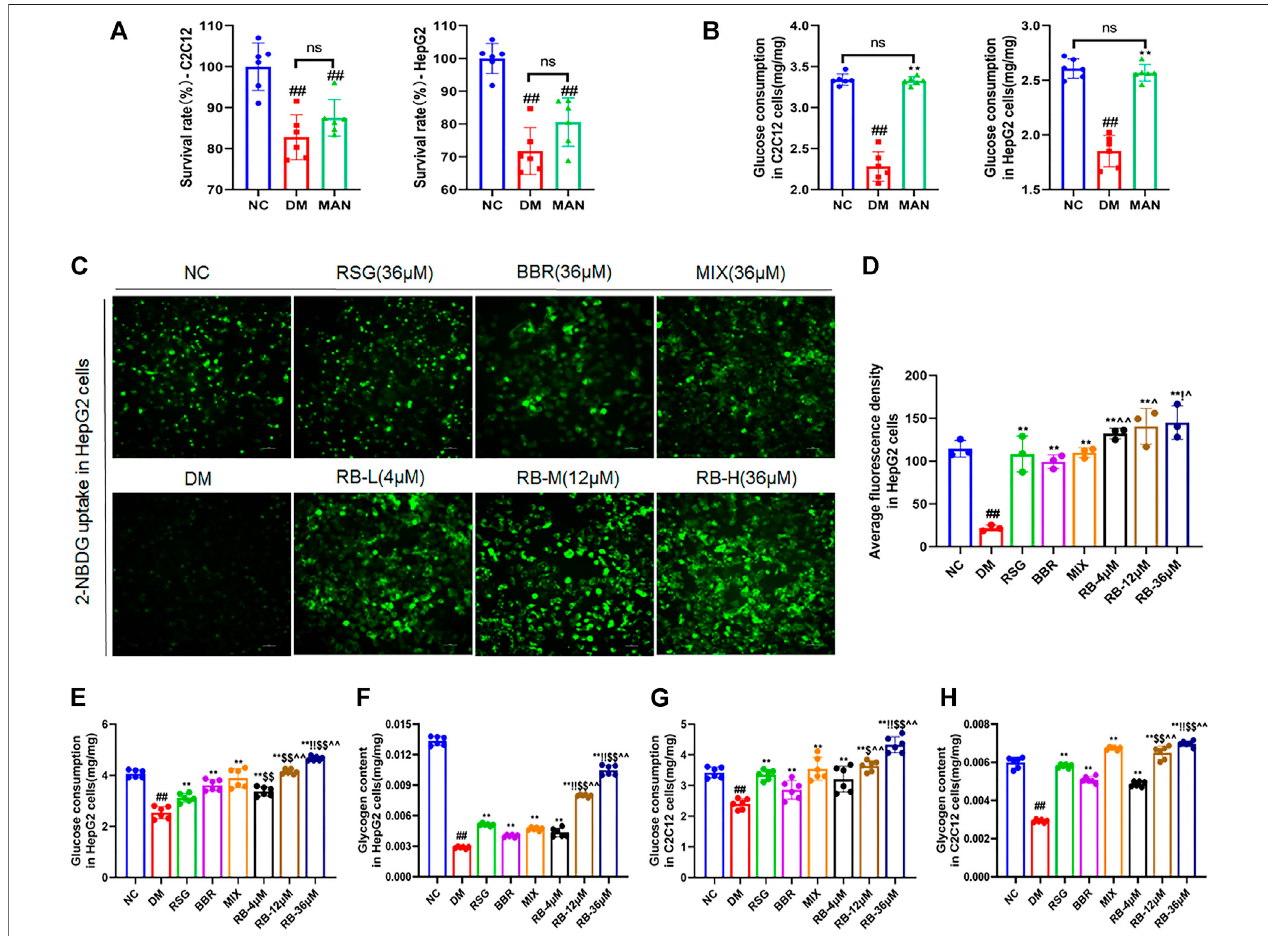
FIGURE5| RBregulated glucosemetabolism invitro . (A,B) Effect ofmannitol (MAN)onthesurvivalrateand glucoseconsumptioninC2C12 andHepG2 cells; (C) RBrestores2-NBDGuptakeininsulin-resistantHepG2cells; (D) Average fl uorescenceintensityof2-NBDGinHepG2cells; (E) GlucoseconsumptioninHepG2cells; (F) GlycogencontentinHepG2cells; (G) GlucoseconsumptioninC2C12cells; (H) GlycogencontentinC2C12cells.Dataareexpressedasthemean±SD. # p < 0.05, ## p < 0.01, vs. NC group; * p < 0.05, ** p < 0.01, vs. DM control group; $ p < 0.05, $$ p < 0.01, vs. RSG group; ^ p < 0.05, ^^ p < 0.01, vs. BBR group; ! p < 0.05, !! p < 0.01, vs. MIX group; ns, no signi fi